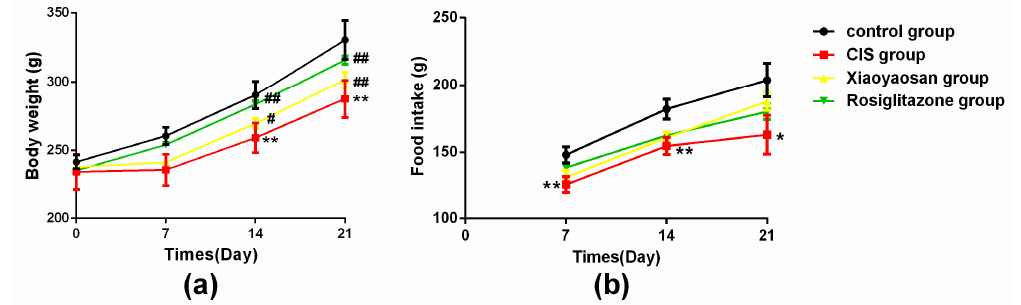
Figure 1. Effect of Xiaoyaosan on stress-induced changes in weight and food intake. The body weight and food intake of rats were recorded during the 21-day CIS period. ( a ) Changes in weekly body weight of each group of rats. ( b ) Changes in weekly food intake of each group of rats. Data are presented as the means ± SEM with seven rats in each group. * p < 0.05 or ** p < 0.001 versus the control group. # p < 0.05 or ## p < 0.001 versus the CIS group.